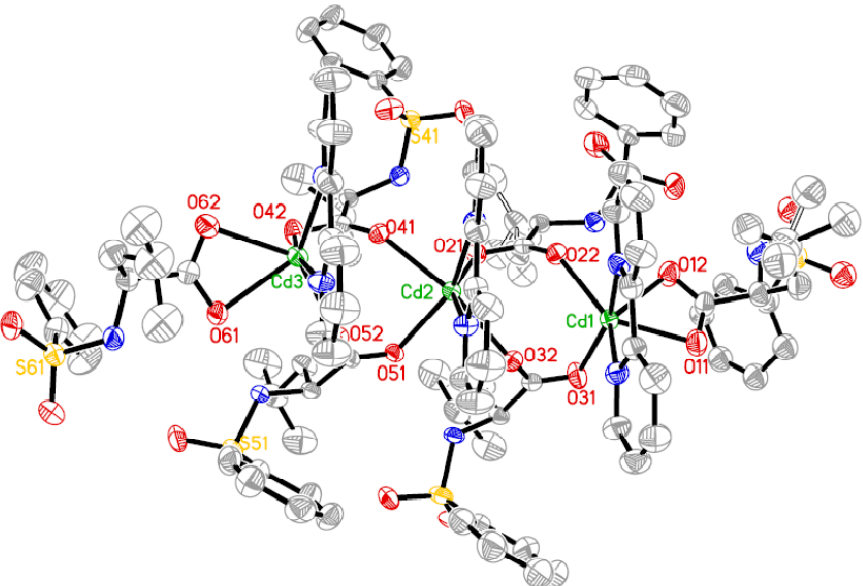
Figure 1. The molecular structure of the Cd (II) complex.